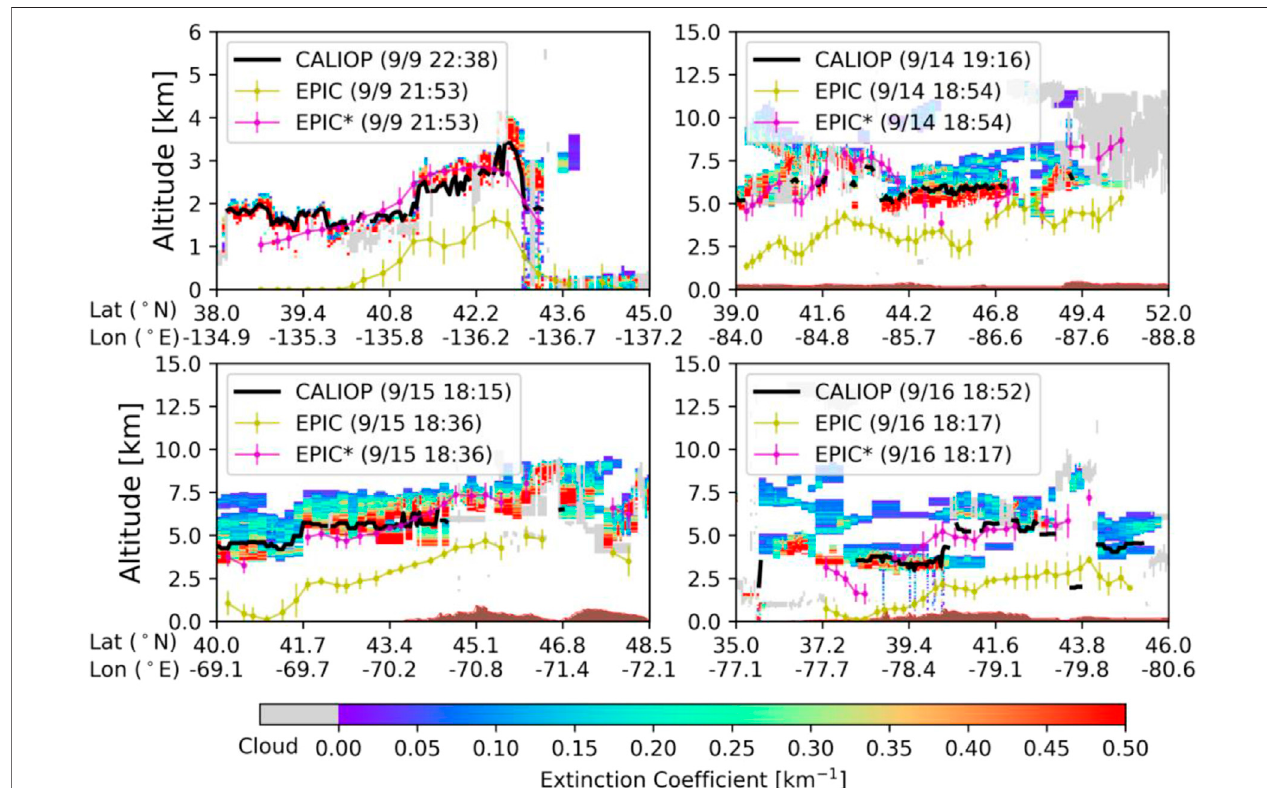
FIGURE 4 | Comparison of EPIC AOCH and CALIOP aerosol extinction pro fi le as well as CALIOP AOCH for September 9 and 14 – 16. The CALIOP tracks are marked by red lines in Figure 3 . The CALIOP AOCH values are represented by black lines, and EPIC AOCH retrievals with the vicarious calibration (EPIC*) and without the vicarious calibration (EPIC) are marked by pink and yellow lines respectively.